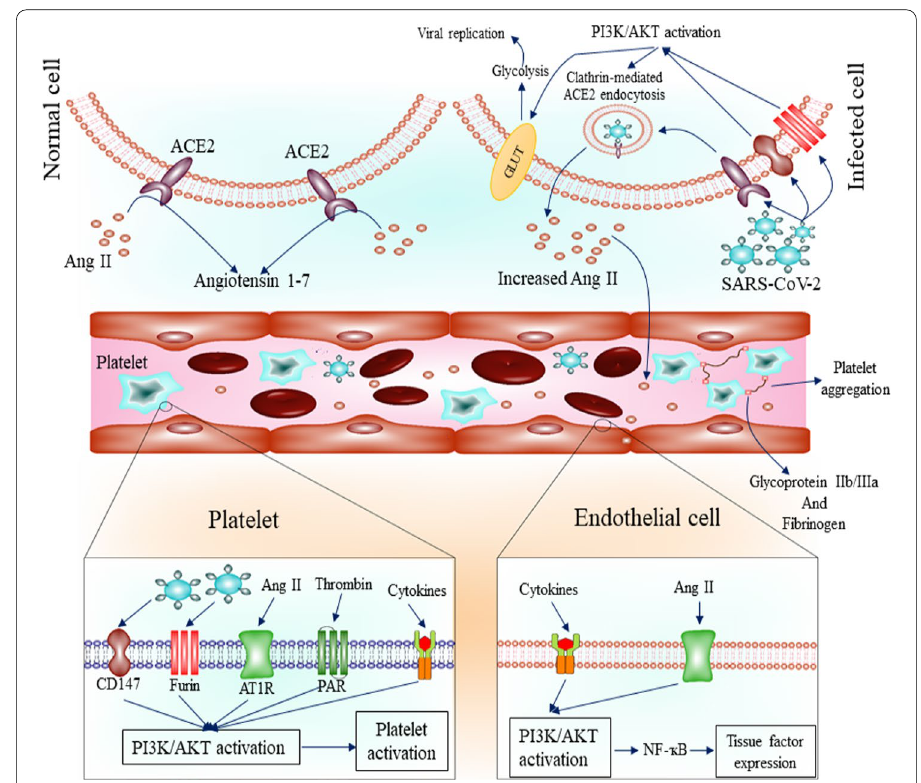
Fig. 1 The role of the PI3K/AKT signaling pathway in blood coagulation in SARS‑CoV‑2 infection. Endocytosis of ACE2 followed by SARS‑CoV‑2 attachment contributes to increased Ang II levels. In addition, elevated levels of thrombin and inflammatory cytokines, such as TNF‑α, IL‑6, IL‑1, and TGF‑β, have been detected during SARS‑CoV‑2 infection. Mentioned factors can activate the PI3K/AKT signaling pathway in platelets, leading to its over‑activation and clot formation. In addition, PI3K/AKT signaling activation by mentioned factors contributes to increased tissue factor expression in endothelial cells. ACE2: angiotensin converting enzyme 2; Ang II: angiotensin II; IL: interleukin; PI3K: phosphatidyl‑inositol‑3‑kinases; TGF‑β: transforming growth factor β; TNF‑α: tumor necrosis factor